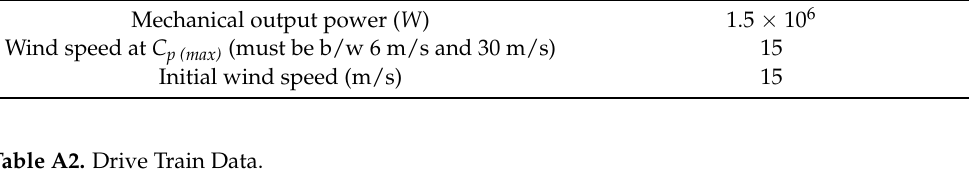
Table A2. Drive Train Data. Wind turbine inertia constant: H Shaft spring constant refers to the high-speed shaft